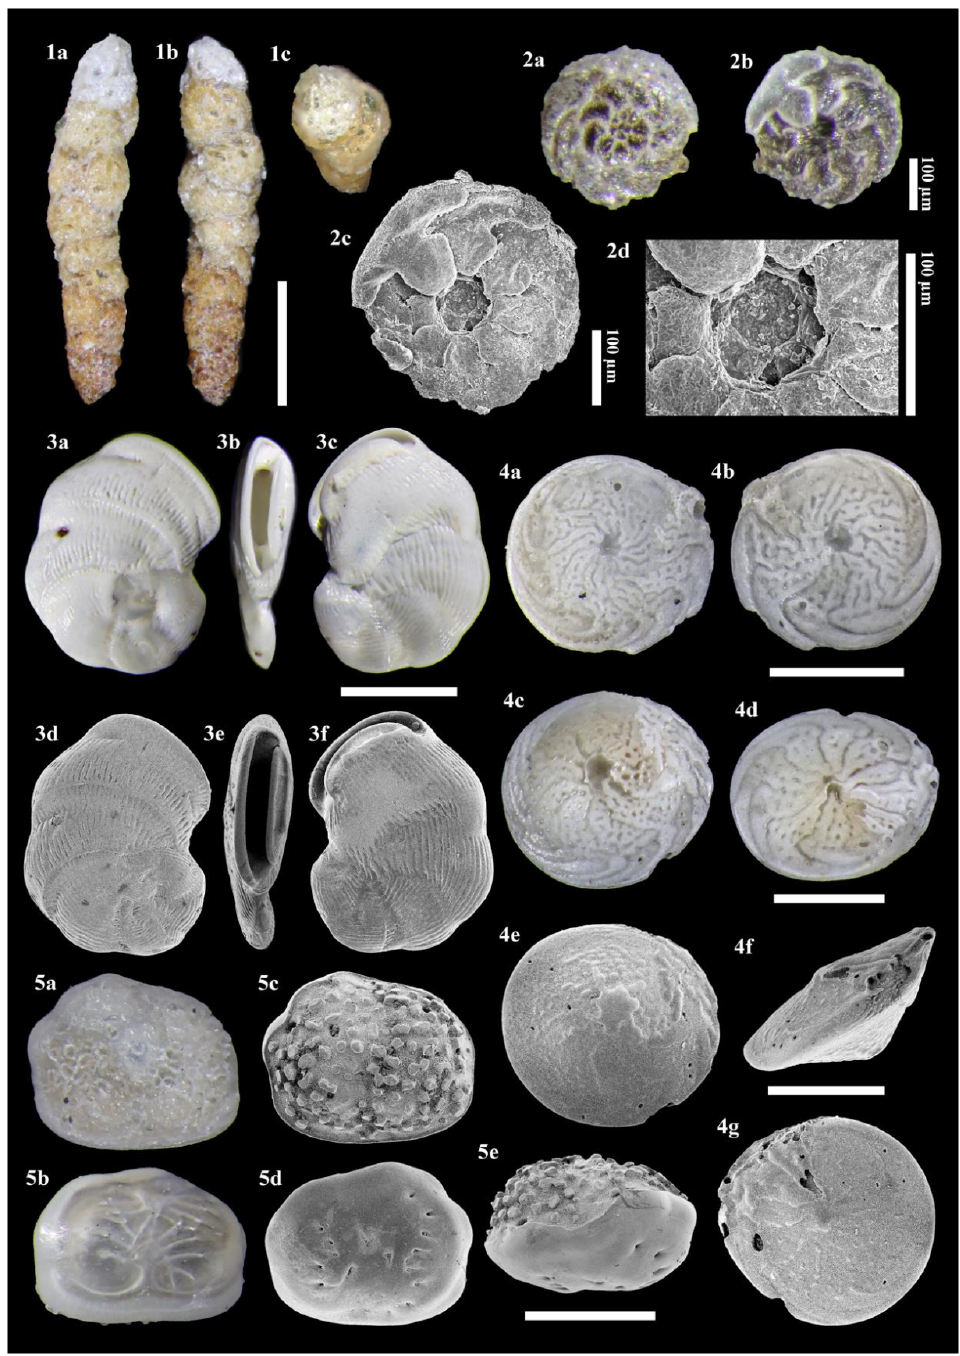
Figure 2. Photomicrograph and SEM image of the five newly recorded species. All scales are 500 µ m unless otherwise noted. 1. ( a – c ) Karrerulina conversa (Grzybowski, 1901); 1 a , 1 b . Side view; 1 c . Apertural side view. 2. ( a – d ) Rotaliammina trumbulli Seiglie, 1977; 2 a . Spiral side view; 2 b . Umbilical side view; 2 c . Umbilical side view, SEM image; 2 d . Close-up of umbilical region. scales: 100 µ m. 3. ( a – f ) Vertebralina striata d’Orbigny, 1826; 3 a . Spiral side view; 3 b . Apertural side view; 3 c . Umbilical side view; 3 d . Spiral side view, SEM image; 3 e . Apertural side view, SEM image; 3 f . Umbilical side view, SEM image. 4. ( a – g ) Amphistegina radiata (Fichtel and Moll, 1798); 4 a . Umbilical side view; 4 b . Spiral side view; 4 c . Umbilical side view; 4 d . Spiral side view; 4 e . Umbilical side view, SEM image; 4 f . Apertural side view, SEM image; 4 g . Spiral side view, SEM image. 5. ( a – e ) Pegidia dubia (d’Orbigny in Fornasini, 1908); 5 a . Spiral side view; 5 b . Umbilical side view; 5 c . Spiral side view, SEM image; 5 d . Umbilical side view, SEM image; 5 e . Lateral side view, SEM